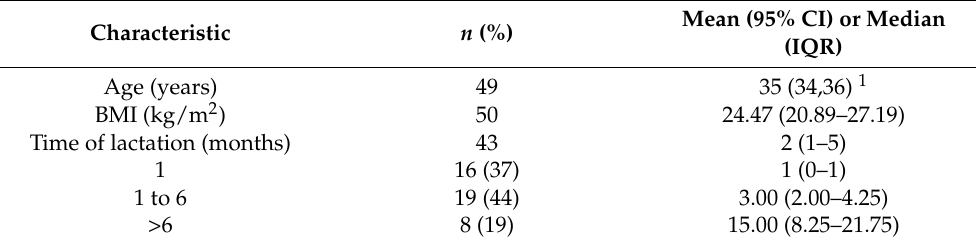
Table 1. Demographic characteristics of the participating women ( n =